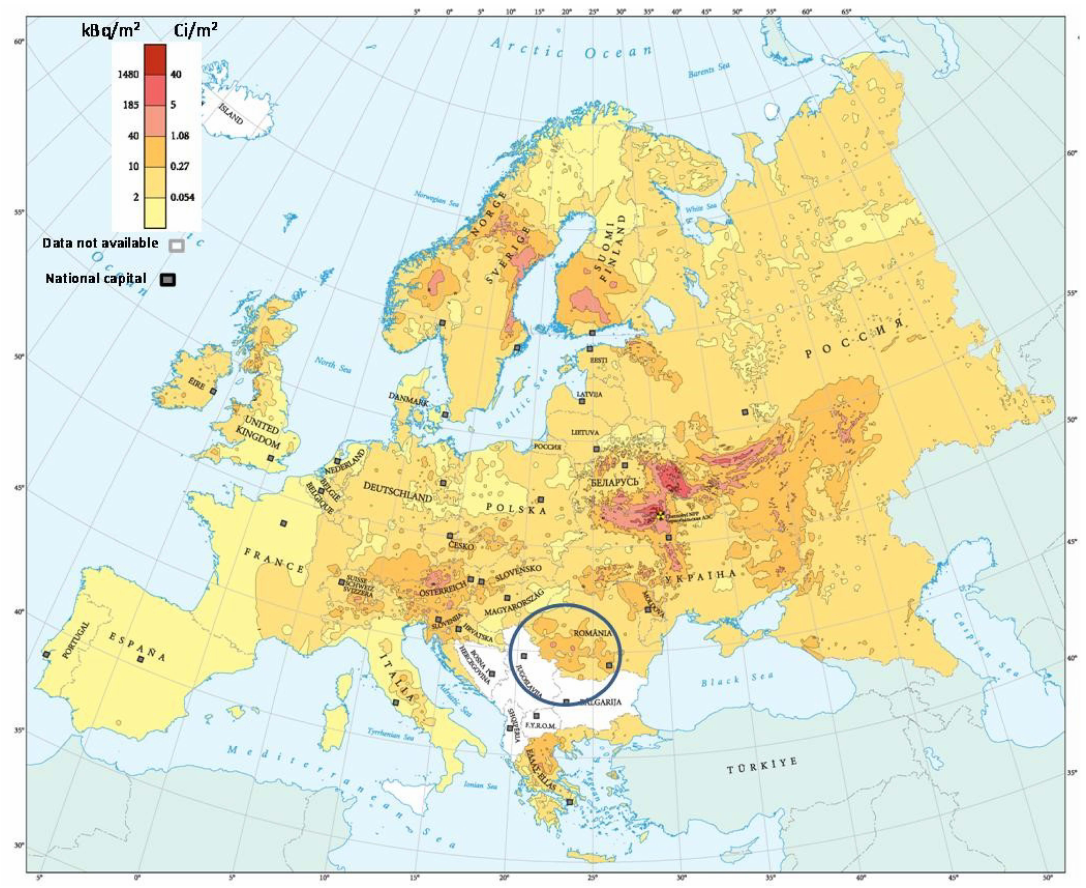
Figure 4. The Atlas map (using the Lambert azimuthal projection) depicting the total cumulative deposition of 137 Cs throughout Europe as a result of the Chernobyl accident from all available data of the REM database corrected for radioactive decay to 10 May 1986 [31]. Blue circle expresses the areas with a density value above the 99th Percentile obtained in Figure